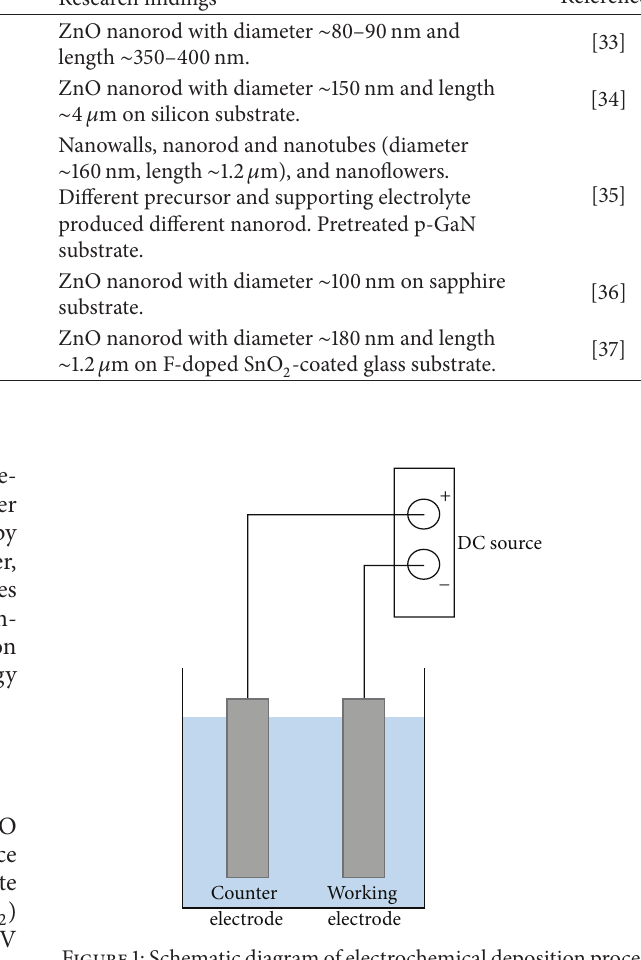
Figure 1: Schematic diagram of electrochemical deposition